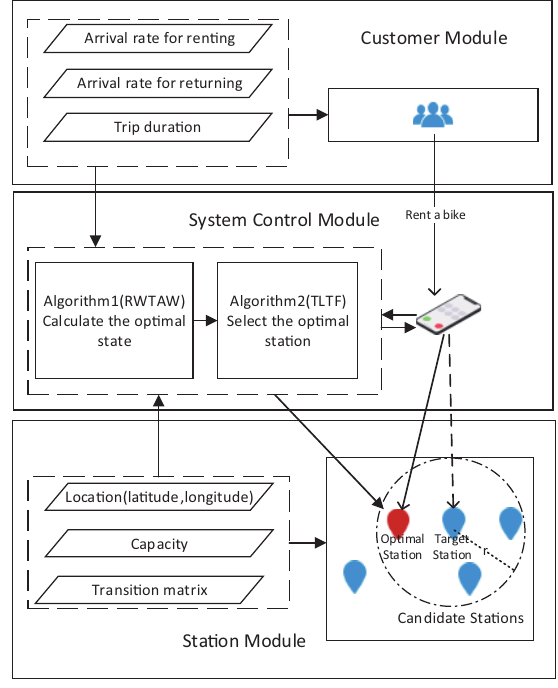
Figure 2. Framework of simulate